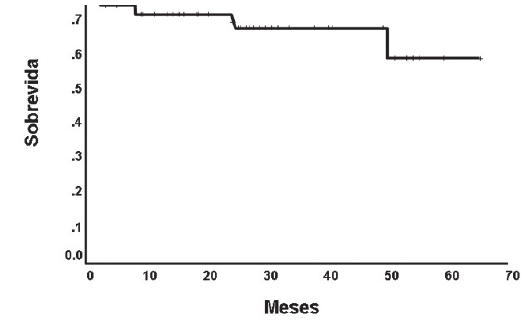
Fig. 1 - Curva atuarial de